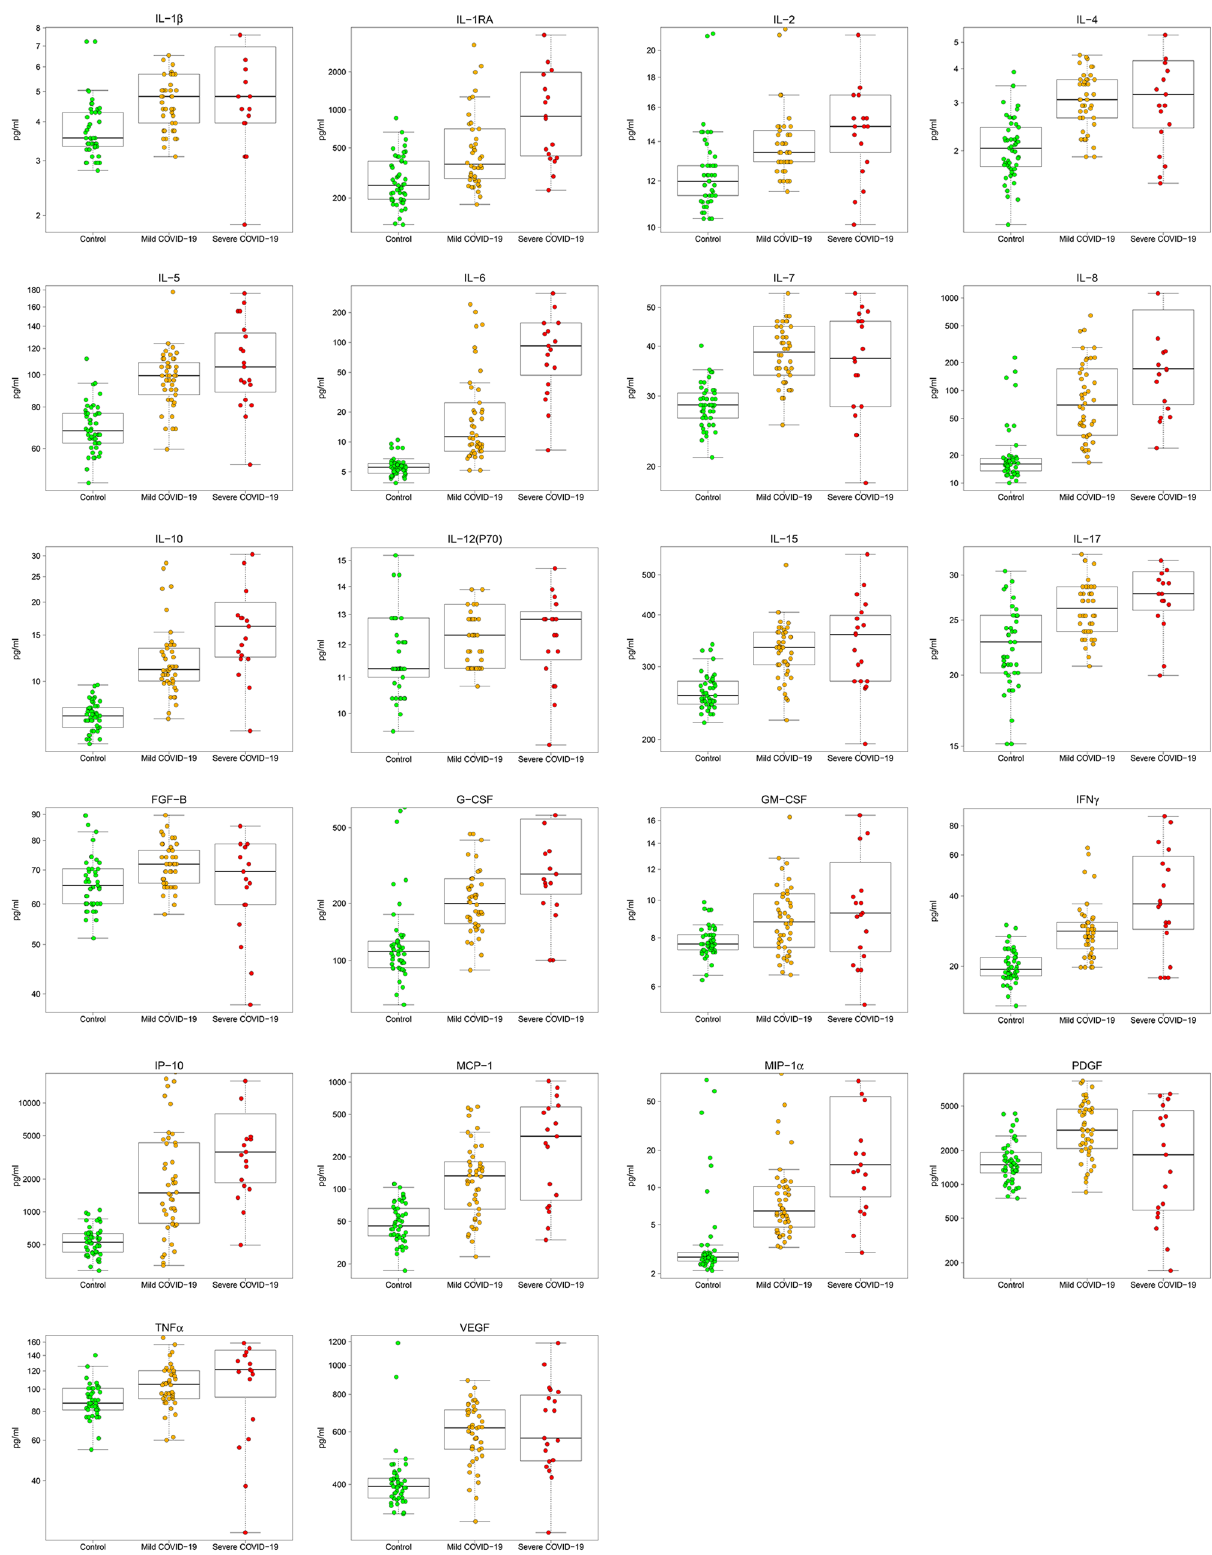
Figure 1. COVID-19 patients display increased trend in circulating cytokines. Box plots denote median and 25th to 75th percentiles (boxes) and minimum to maximum (whiskers) and Jonckheere–Terpstra trend test was performed to analyse data. Figure reports only factors with statistically significant different trends. p values and the number of patients for each group are reported in Table